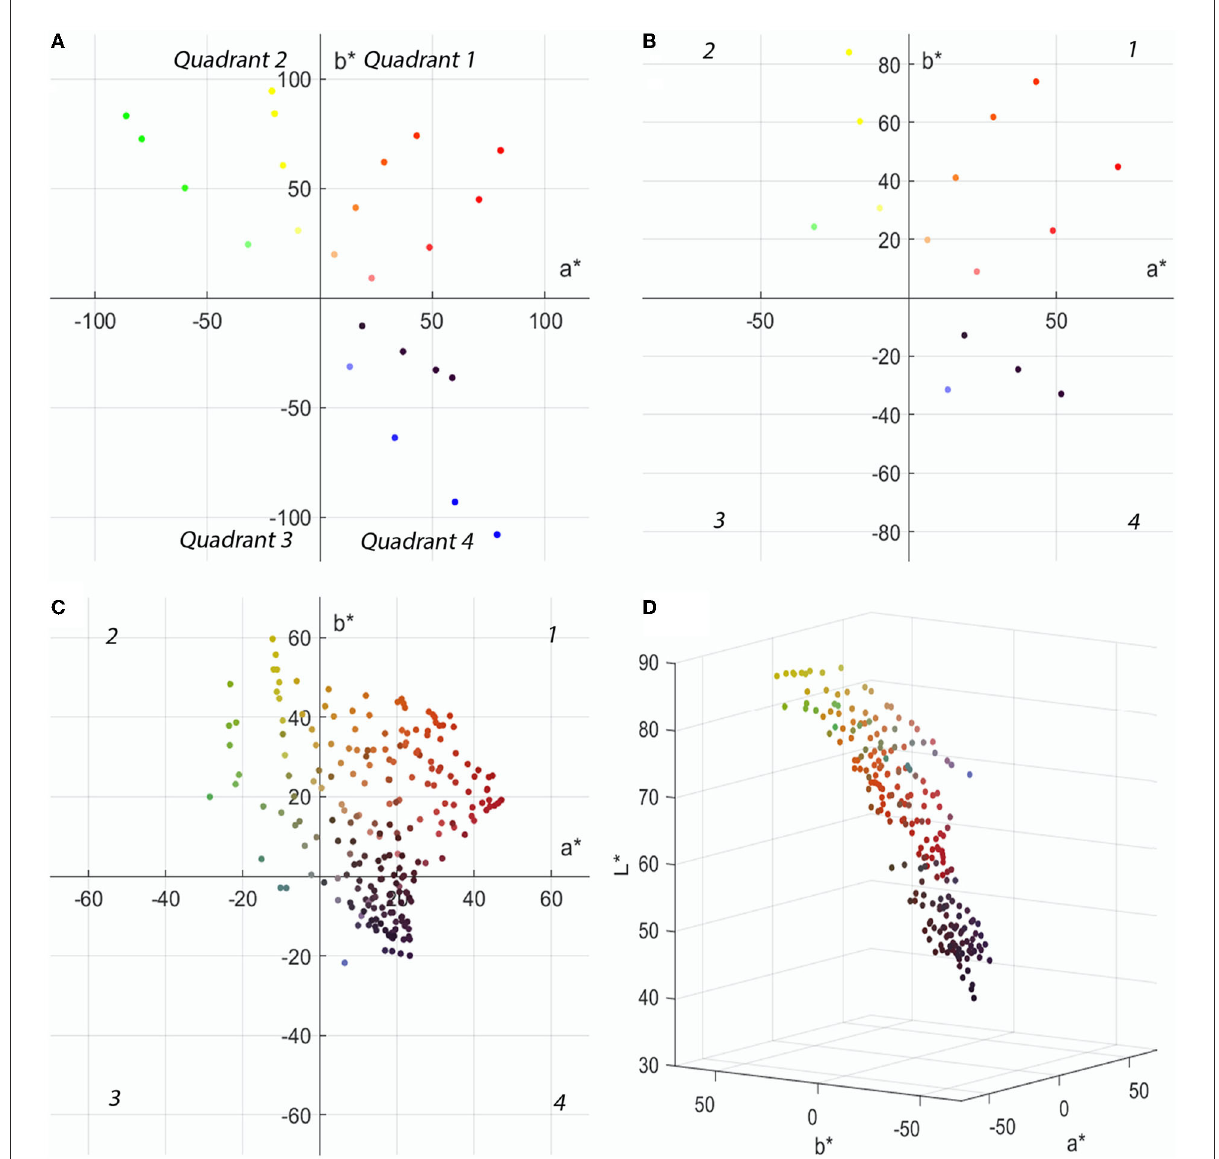
FIGURE2 The color distribution in CIELAB space: (A) Two-dimensional distribution of 24 colors in CIELAB space. (B) Two-dimensional distribution of 15 colors in CIELAB space. (C) Two-dimensional distribution of 210 colors in CIELAB space. (D) Three-dimensional distribution of 210 colors in CIELAB